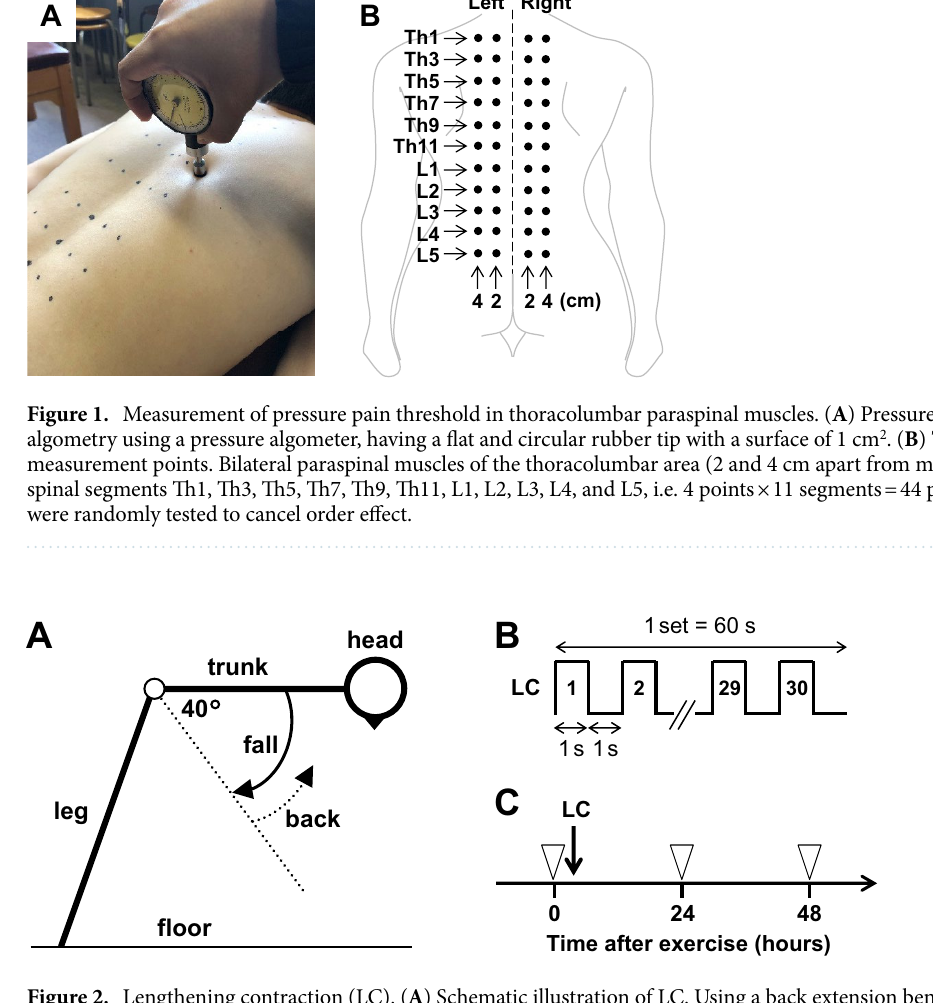
Figure 2. Lengthening contraction (LC). ( A ) Schematic illustration of LC. Using a back extension bench, participants allowed their trunk to fall from a starting position (parallel to the floor) to 40° flexion position, and then returned to the starting position. This “fall and back” cycle was performed in 1 s, and followed by a rest period of 1 s. During the rest period, an experimenter held the subject’s trunk at the starting position. ( B ) Protocol for LC. Using a sound-guided metronome, the LC cycle was repeated 30 times in one set (i.e. 2 s × 30 times = 60 s). The LC set was repeated with inter-set intervals of 1 min until participants could not continue the exercise. ( C ) Experimental schedule. Pressure pain threshold was measured 0 (before), 24, and 48 h after